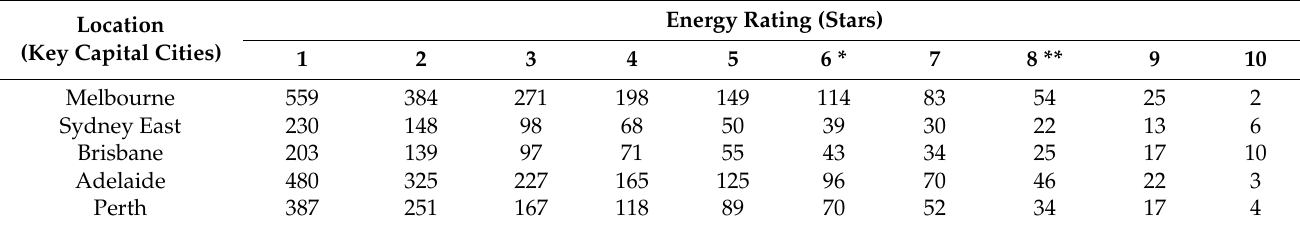
Table 1. Australian housing’s NatHERS energy efficiency star band criteria (thermal load in MJ/m 2 /year).